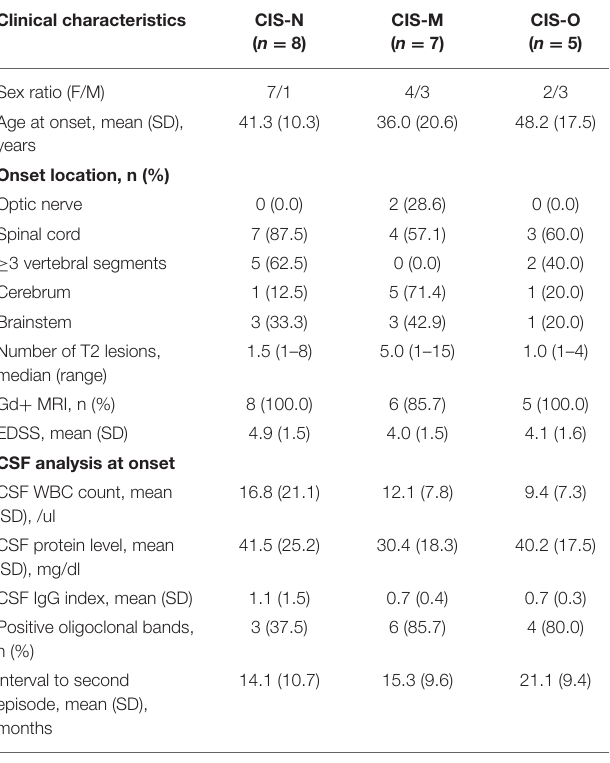
TABLE 3 | Characteristics of three groups of clinically isolated syndromes (CIS) patients who relapsed during follow-up. Clinical